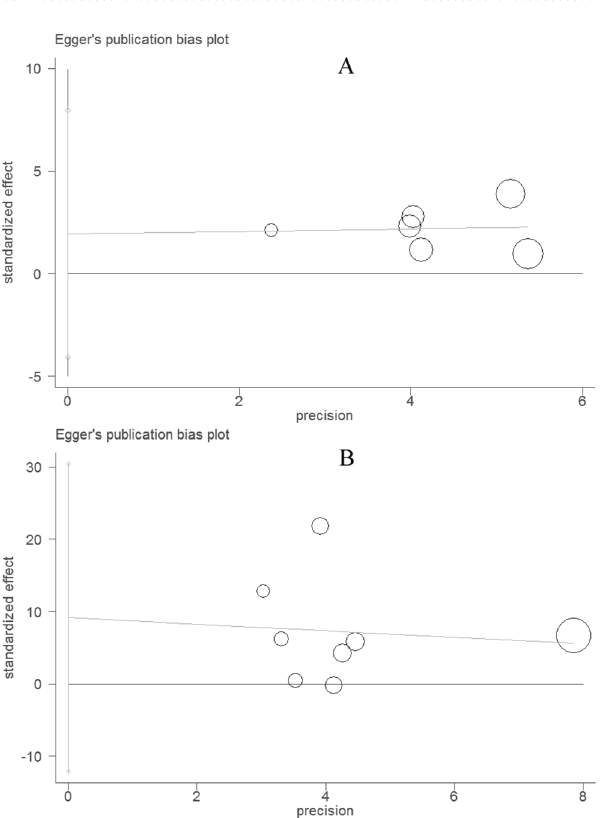
Figure 2. Meta-analysis results of the association between the PTB risk and MIF-173G/C gene polymorphism (CC + CG vs. GG).